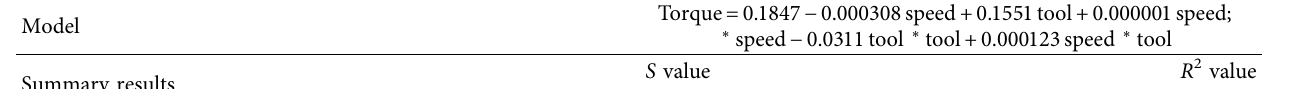
Table 12: Regression model and summary results for Torque.